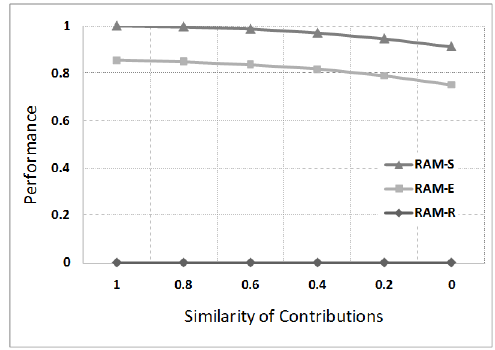
Fig. 6. Evaluation of the performance metric versus diversity of individual contributions.